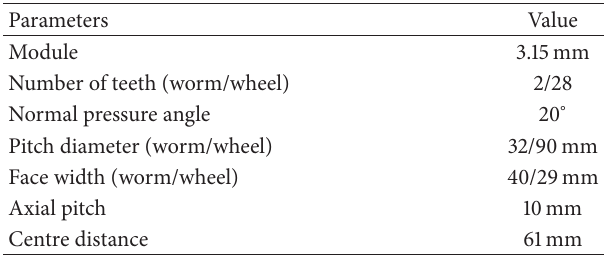
Table 4: Worm and wheel gear specifications. Table 5: Elements of the universal test